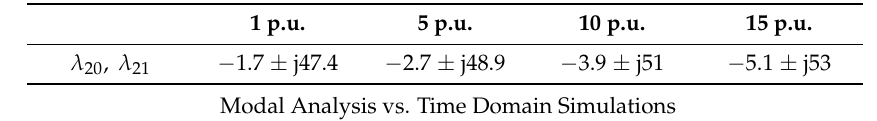
(cid:3043)(cid:3049)(cid:2869),(cid:2870) = (cid:1837) (cid:3036)(cid:3049)(cid:2869),(cid:2870) = 1 p.u. ( b ) (cid:1837) (cid:3043)(cid:3049)(cid:2869) = (cid:1837) (cid:3043)(cid:3049)(cid:2870) = 10 p.u. ( c ) (cid:1837) (cid:3036)(cid:3049)(cid:2869) = (cid:1837) (cid:3036)(cid:3049)(cid:2870) = 4 p.u.